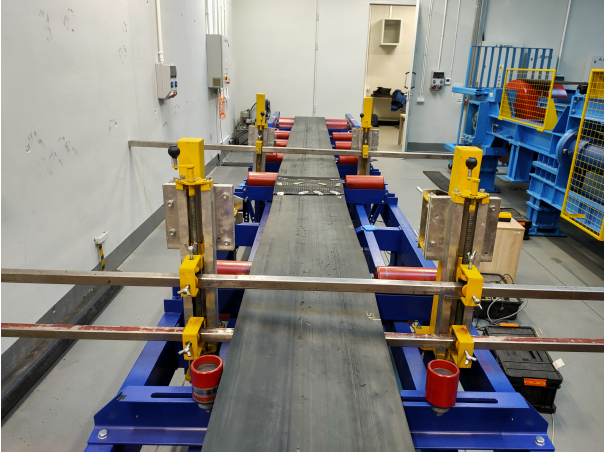
Figure 3. The device for non-invasive magnetic diagnostic of the